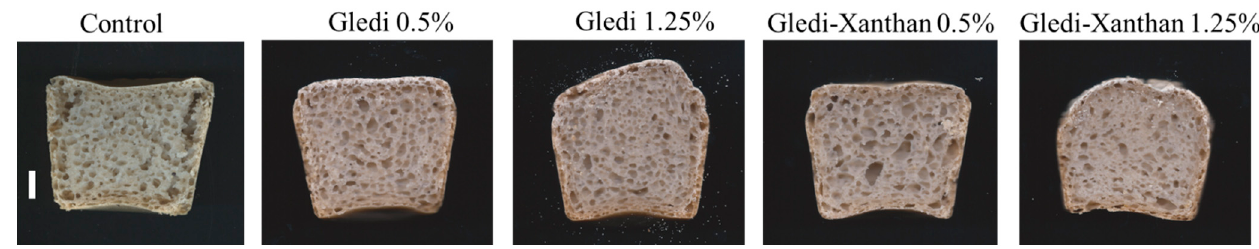
Figure 2. Representative images of gluten-free bread. Bar: 1 cm. Table 5. Gluten-free bread textural parameters.